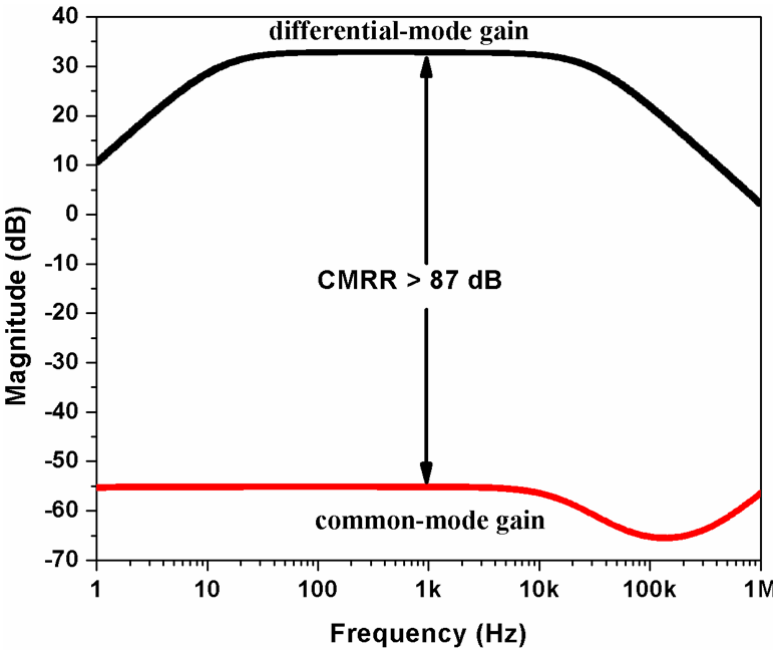
Figure 16. Common mode rejection ratio (CMRR) measured in the readout electrical circuit of the CMOS chip.